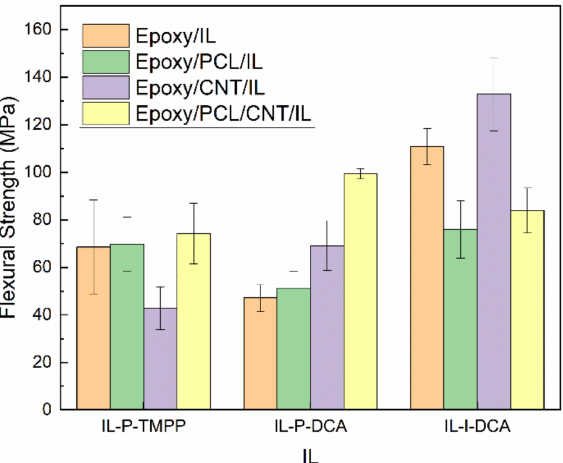
Figure 6. The flexural strength of the epoxy/PCL/CNT NCs cured with the three different ILs, and of the reference epoxy/IL, epoxy/PCL/IL and epoxy/CNT/IL